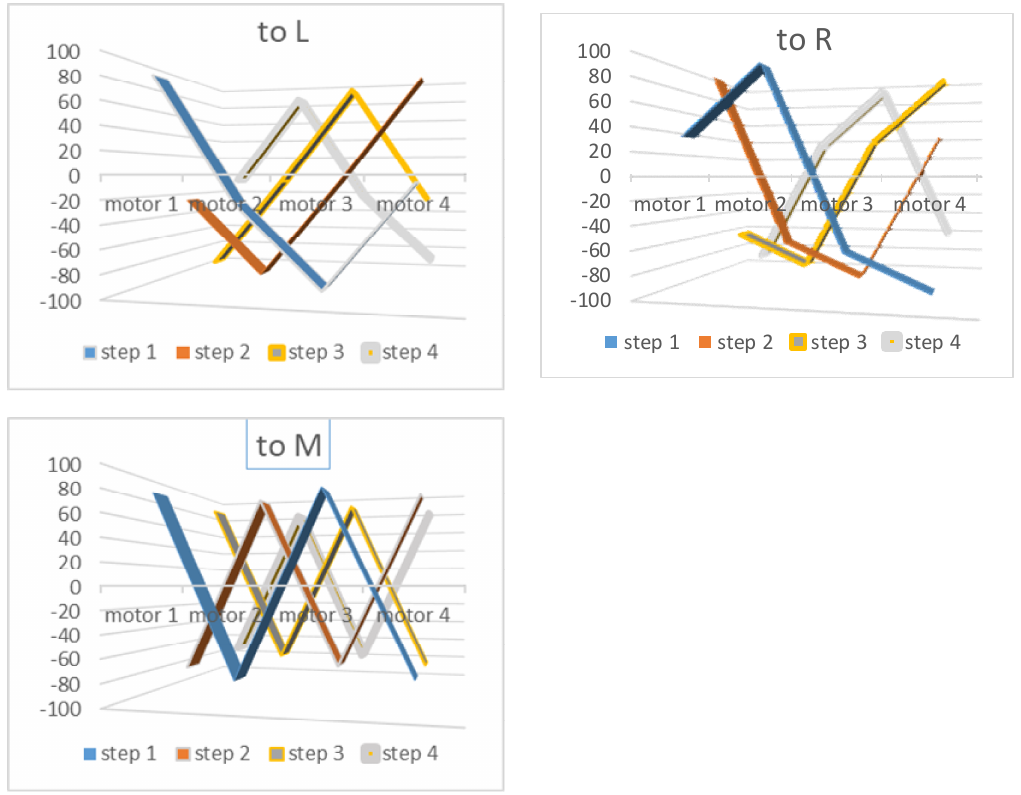
Figure 11. Rotation angles ( y -axis) of different motors ( x -axis) obtained via the ANM system (general learning).